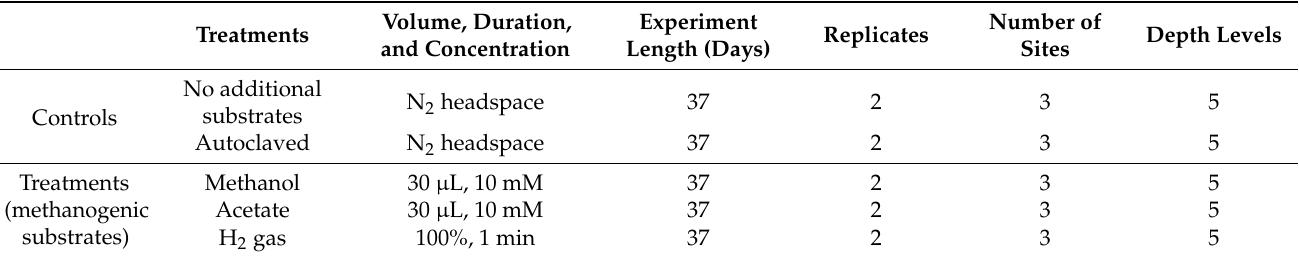
Table 3. Treatment conditions for sediment slurry